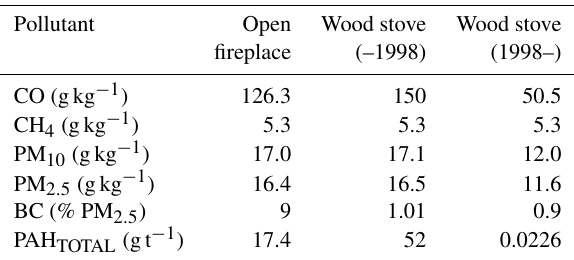
Table 1. Emission factors as amount of pollutant per amount of dry wood (Seljeskog et al.,